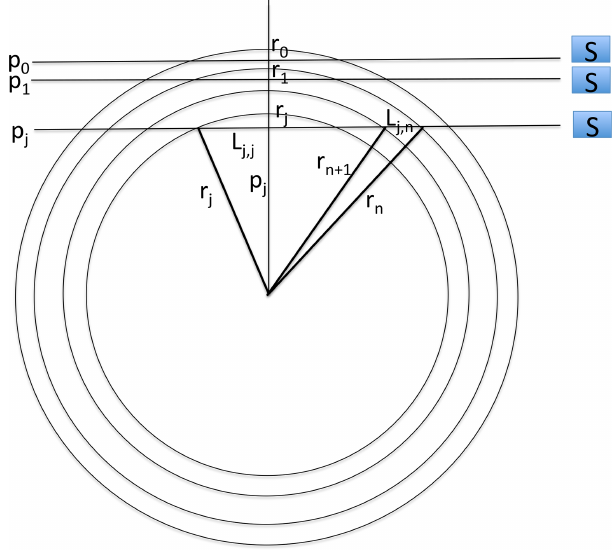
Figure B1. Geometry of the LOS at the limb of an emission orga- nized in spherical layers. The various LOS are obtained either by drifting the observer S into an orbit with a fixed inertial direction (case of GOMOS/Envisat) or by angular scanning (case of SCIA-